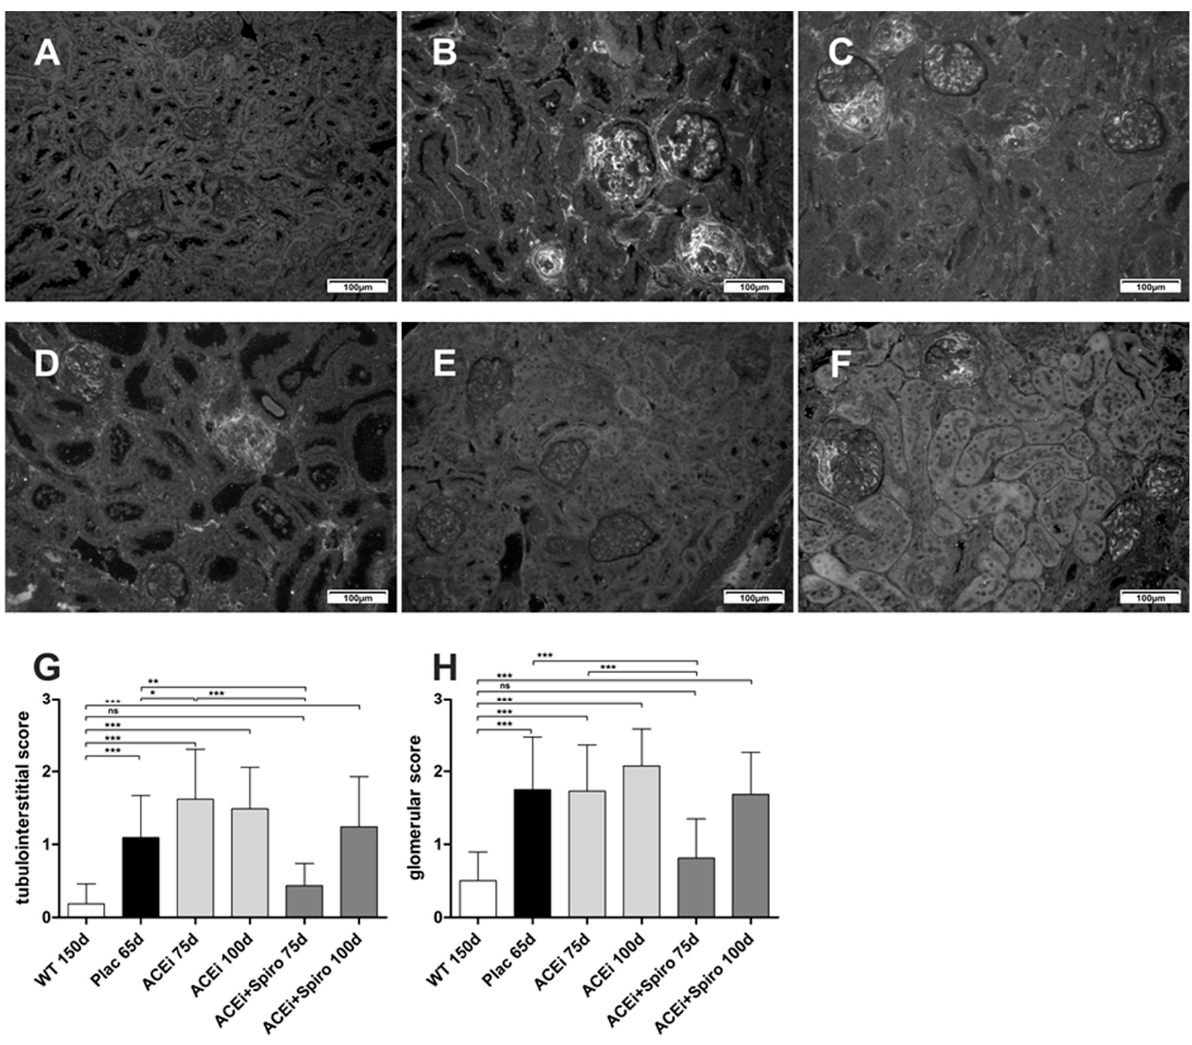
Figure 4. Therapeutic effect on scar tissue formation during pathogenesis of AS. Immune-fluorescence staining of fibronectin, magnification 200-fold. ( A ) wildtype control; ( B ) Alport mice, ACEi 75 days; ( C ) Alport mice, ACEi 100 days; ( D ) Alport mice, Plac (untreated); ( E ) Alport mice, ACEi+Spiro 75 days; ( F ) Alport mice, ACEi-Spiro 100 days; ( G ) score of tubulointerstitial fibrosis ( n = 3 for each group); ( H ) score of glomerulosclerosis and fibrosis ( n = 3 for each group); *** p < 0.001; ** p < 0.01; * p < 0.05.